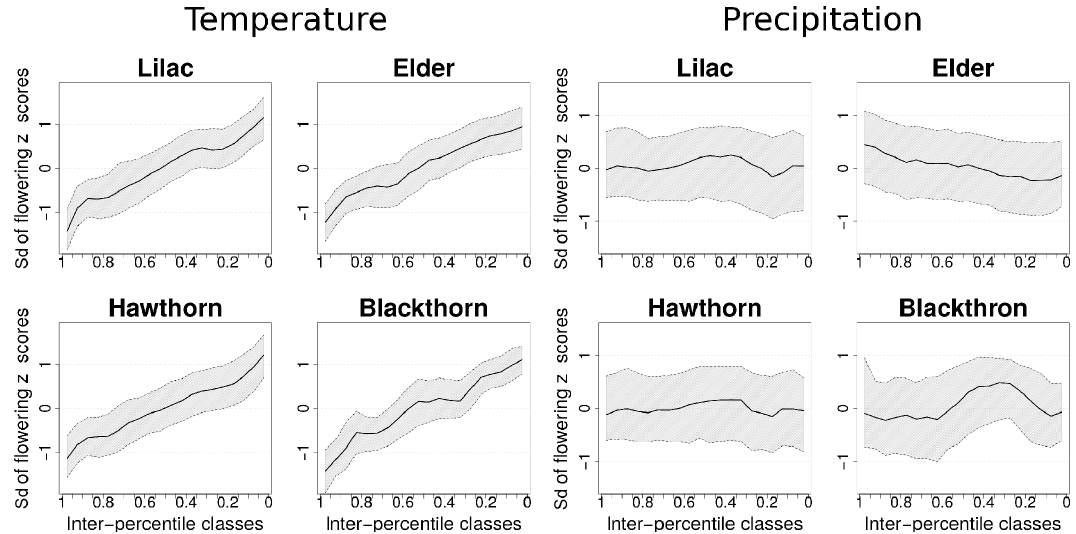
Figure 3. Distribution of standardized flowering dates (median plus 25% / 75% interquartile range) of the four shrub species in dependence on spring mean temperature and spring precipitation sum. Note the inverted direction of the x axes.